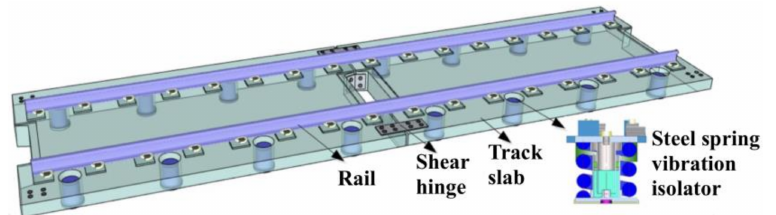
Figure 2. Schematic diagram of the steel-spring-floating slab track